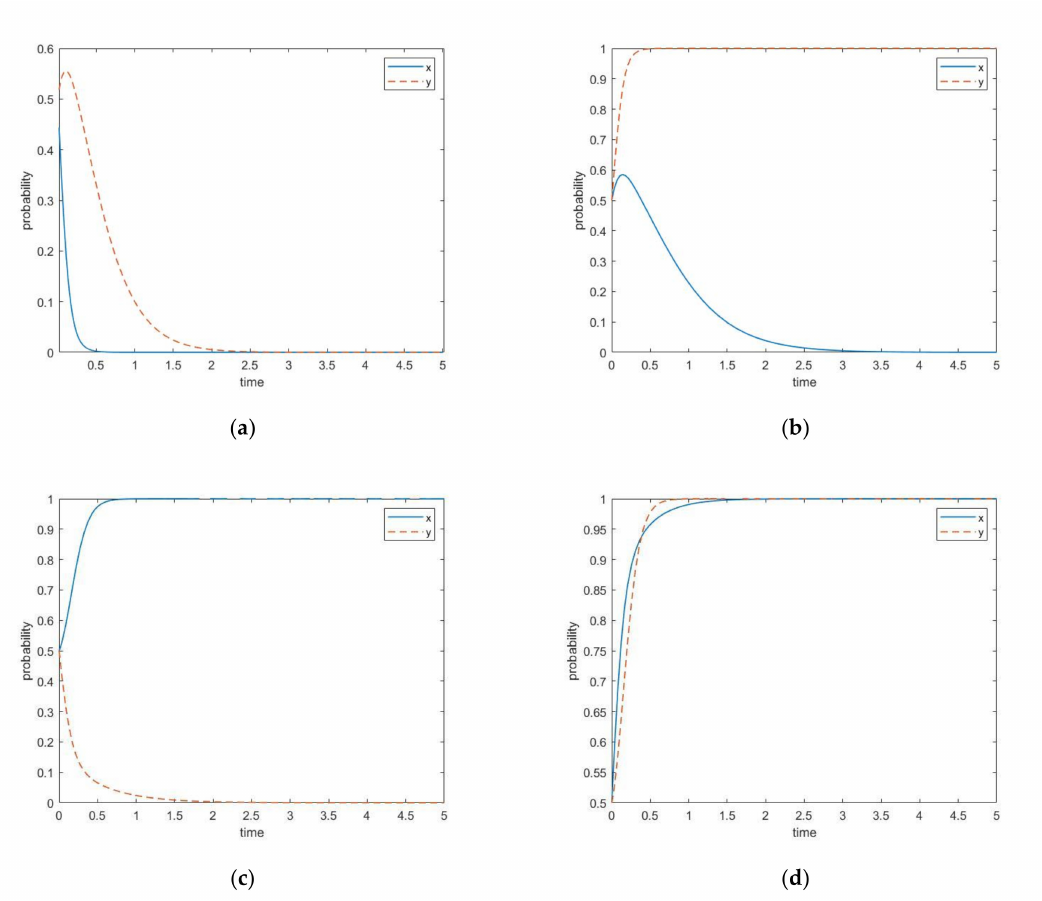
Figure 2. The evolutionary paths of the four asymptotically stable states. ( a ) Asymptotically stable state ( 0,0 ) ; ( b ) asymptotically stable state ( 0,1 ) ; ( c ) asymptotically stable state ( 1,0 ) ; ( d ) asymptotically stable state ( 1,1 )